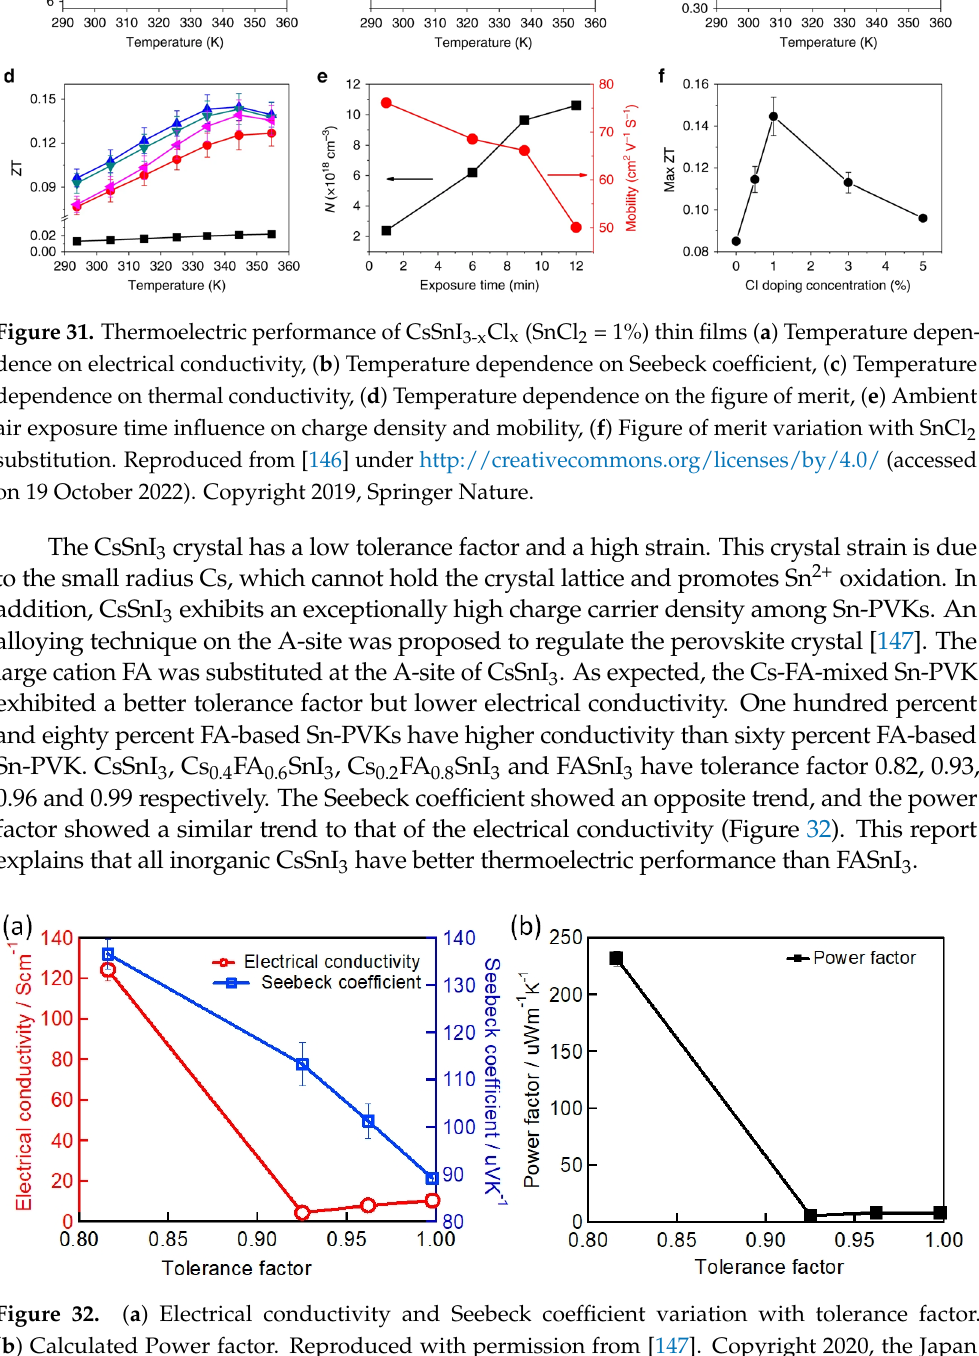
Figure 30. ( a ) The measurement of electrical conductivity and Seebeck coefficient under variable temperature, ( b ) The measurement of thermal conductivity under variable temperature, ( c ) Calculated power factor under variable temperature, ( d ) Calculated figure of merit under variable temperature. Reproduced with permission [144]. Copyright 2020, American Chemical Society.